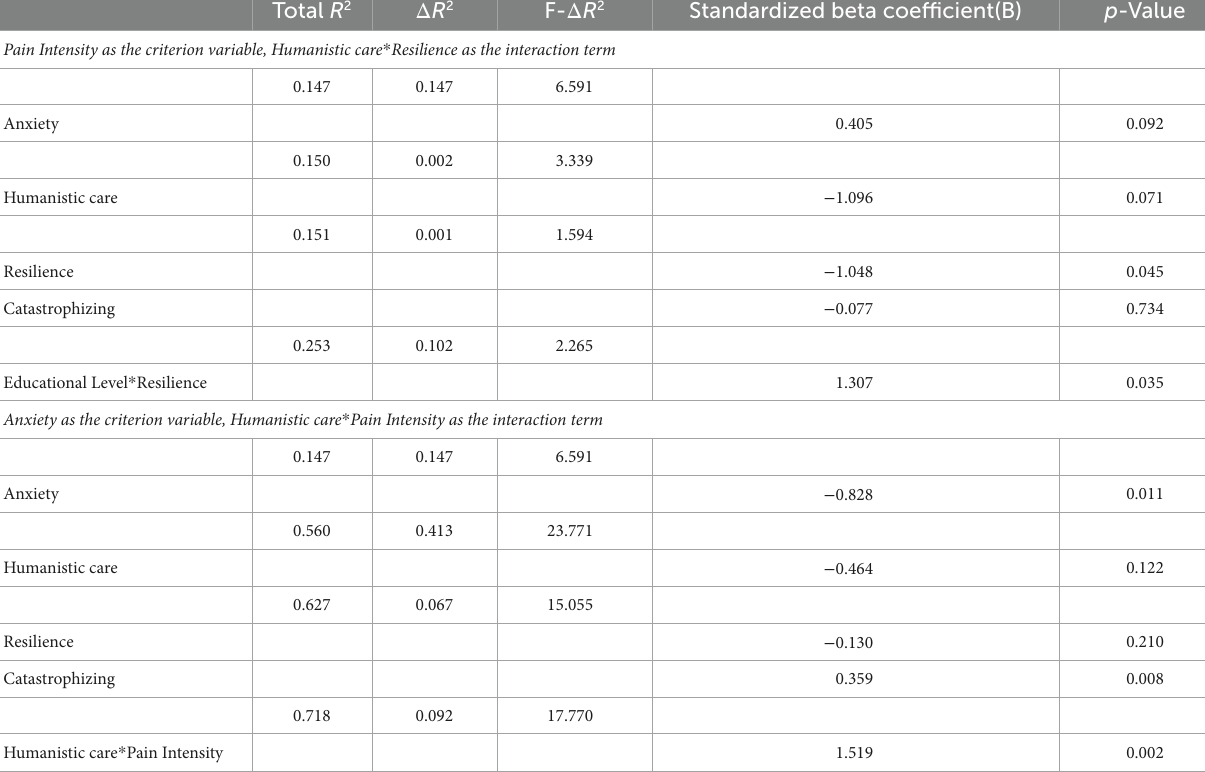
TABLE 5 The moderating effect of humanistic care on the relationship among pain intensity, psychological factors, and psychological functioning. Total R